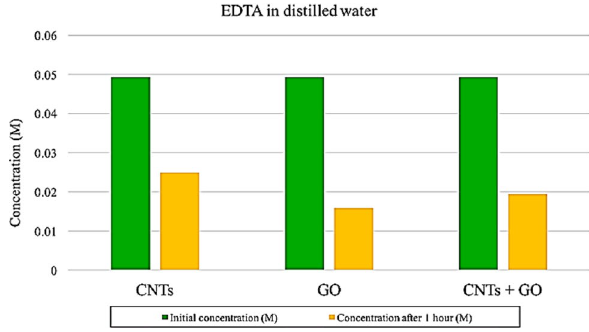
Fig. 3 Concentration of EDTA in DW before and after 1 h of stirring